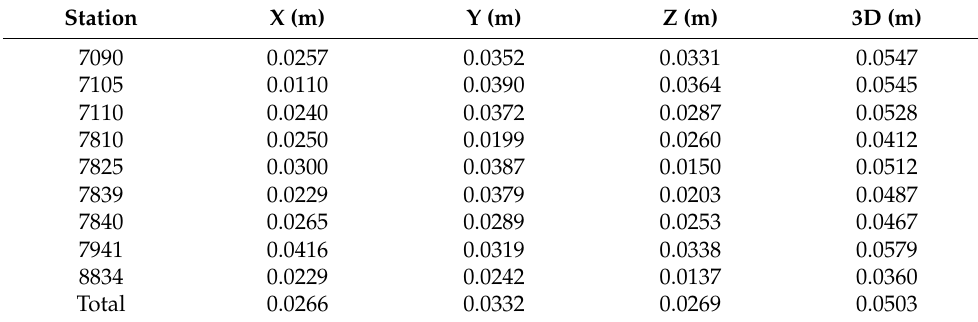
Table 9. RMS of SLR 3D validation